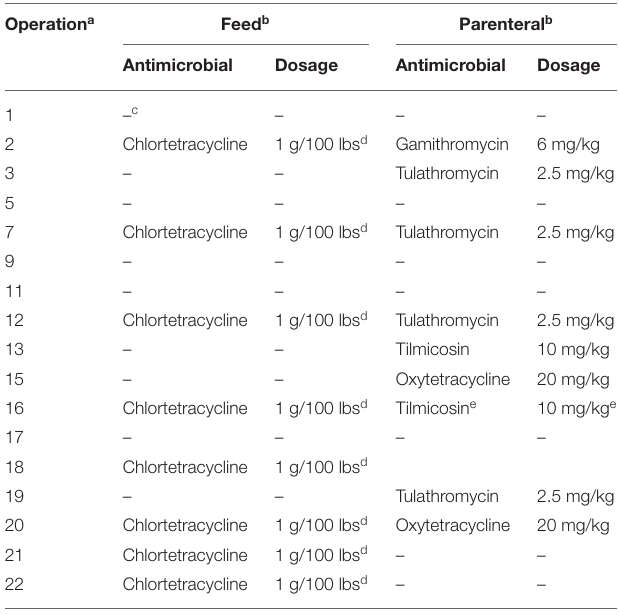
TABLE 2 | Antimicrobial treatment protocols adopted at WEANING/INDUCTION at each cow–calf